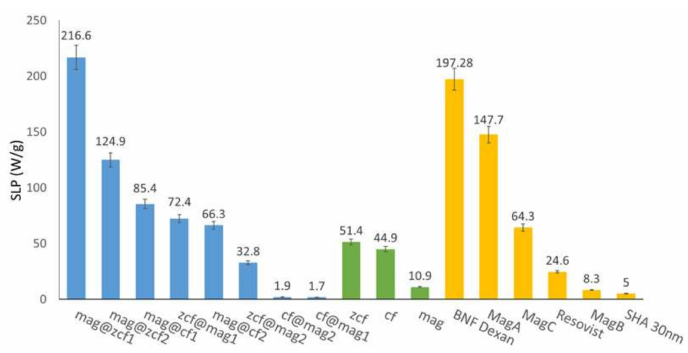
Figure 6. Comparison of SLP values of core nanoparticles, bi-magnetic core-shell structured MFNs, and commercial under the action of magnetic field of strength 40 kA / m and frequency 97